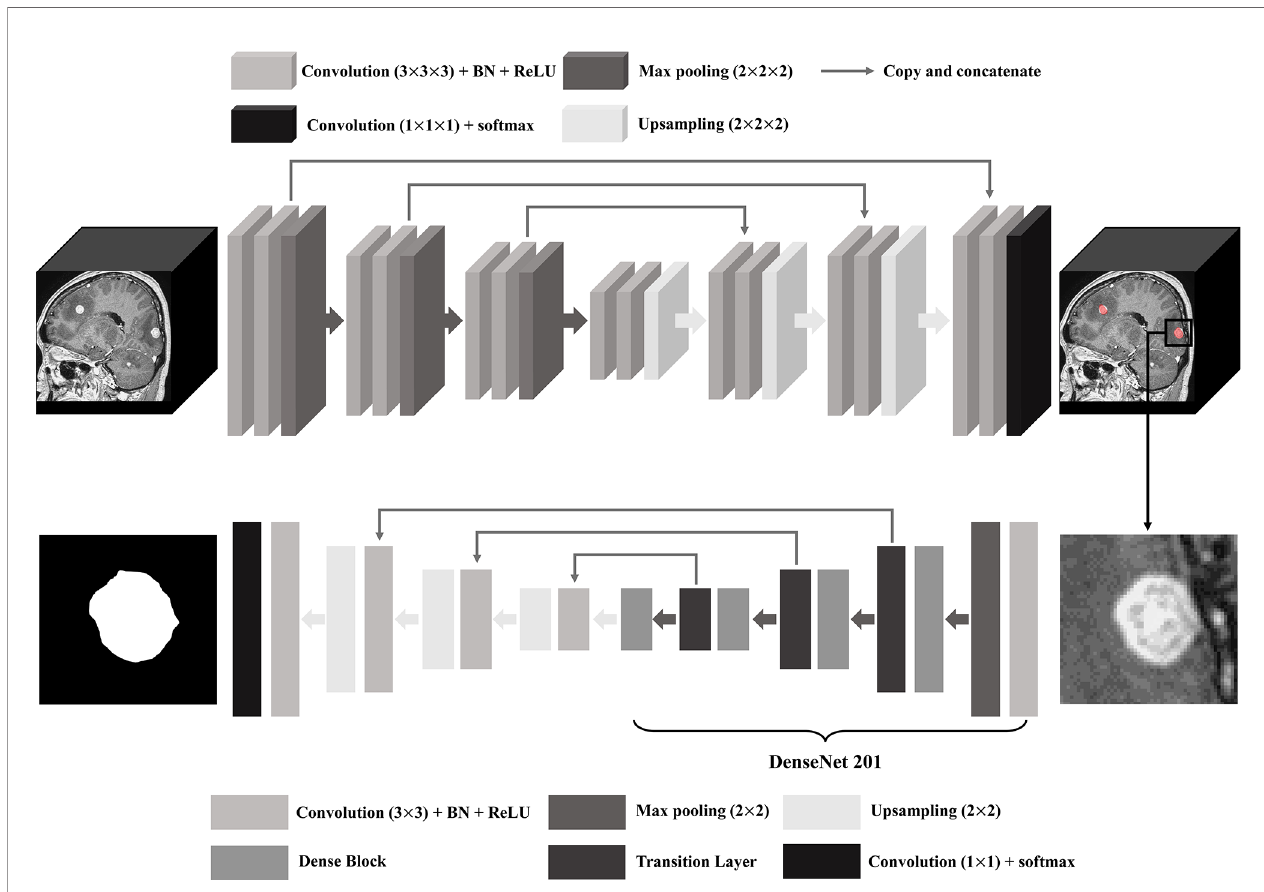
FIGURE 2 | U-Net architecture for brain metastasis (BM) detection and segmentation. BN, batch normalization; ReLU, recti fi ed linear